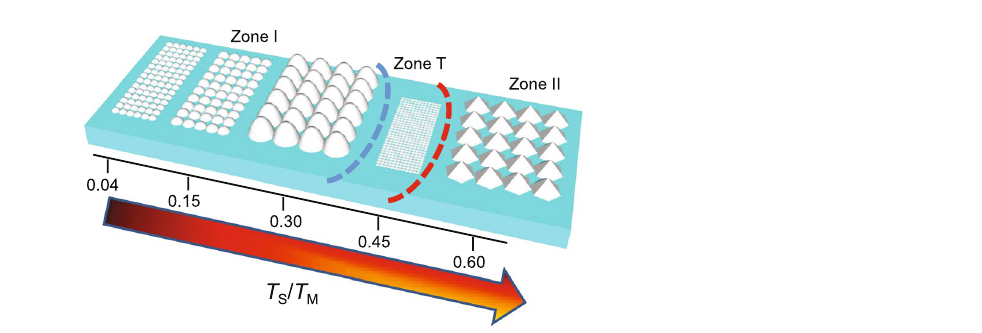
Figure 2. Schematic representation of a zone structure diagram for Al sputtered at constant pressure and power but different substrate temperatures showing the evolution of the grain structure with substrate temperature to melting temperature ( T S / T M ) ratios. In Zone I, the grains are porous and become larger as T S / T M increases. The transition zone (T) has densely packed and smaller grains and in Zone II the film crystallizes and have large columnar